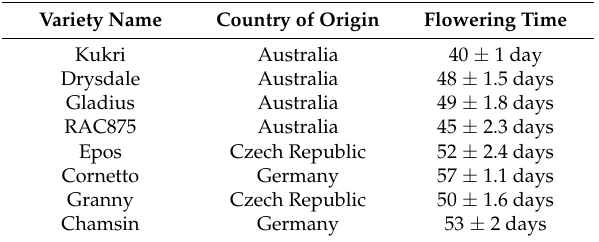
Table 1. List of summer wheat varieties (all bread wheat) used in this study. Their respective country of origin and flowering time are